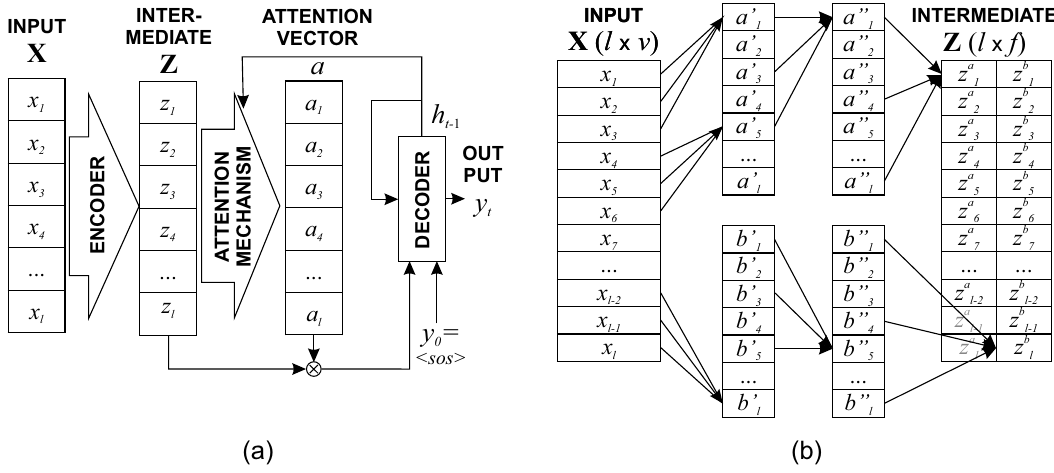
Figure 1. Scheme of the proposed neural network architecture. ( a ) Global scheme of the encoder-decoder architecture including the attention mechanism. The input matrix, X , which contains l vector elements ( x 1 , x 2 . . . x l ), is transformed into an intermediate code, Z = z 1 , z 2 . . . z l . Then, the attention mechanism selects the importance, a , of each tuple at each time, t . Using both values, the decoder produces the output at each instant, y t . The hidden state of the decoder at the previous instant, h t − 1 , is fed into the attention mechanism and into the decoder. <sos> means “start of sequence”. ( b ) Outline of the proposed Causal Feature Extractor for the part of the encoder, in this case with 3 layers. The input is matrix X , with l vectors of size v . There are two independent sub-nets (upper and lower), each of which generates f /2 features for each input vector. They are convolutional NNs which are causal ( a uses the previous values, and b uses the later values) and dilated (the step in the 1st layer is 1, in the 2nd layer 2, and in the 3rd layer 4). The output is the code Z , with f features for each input